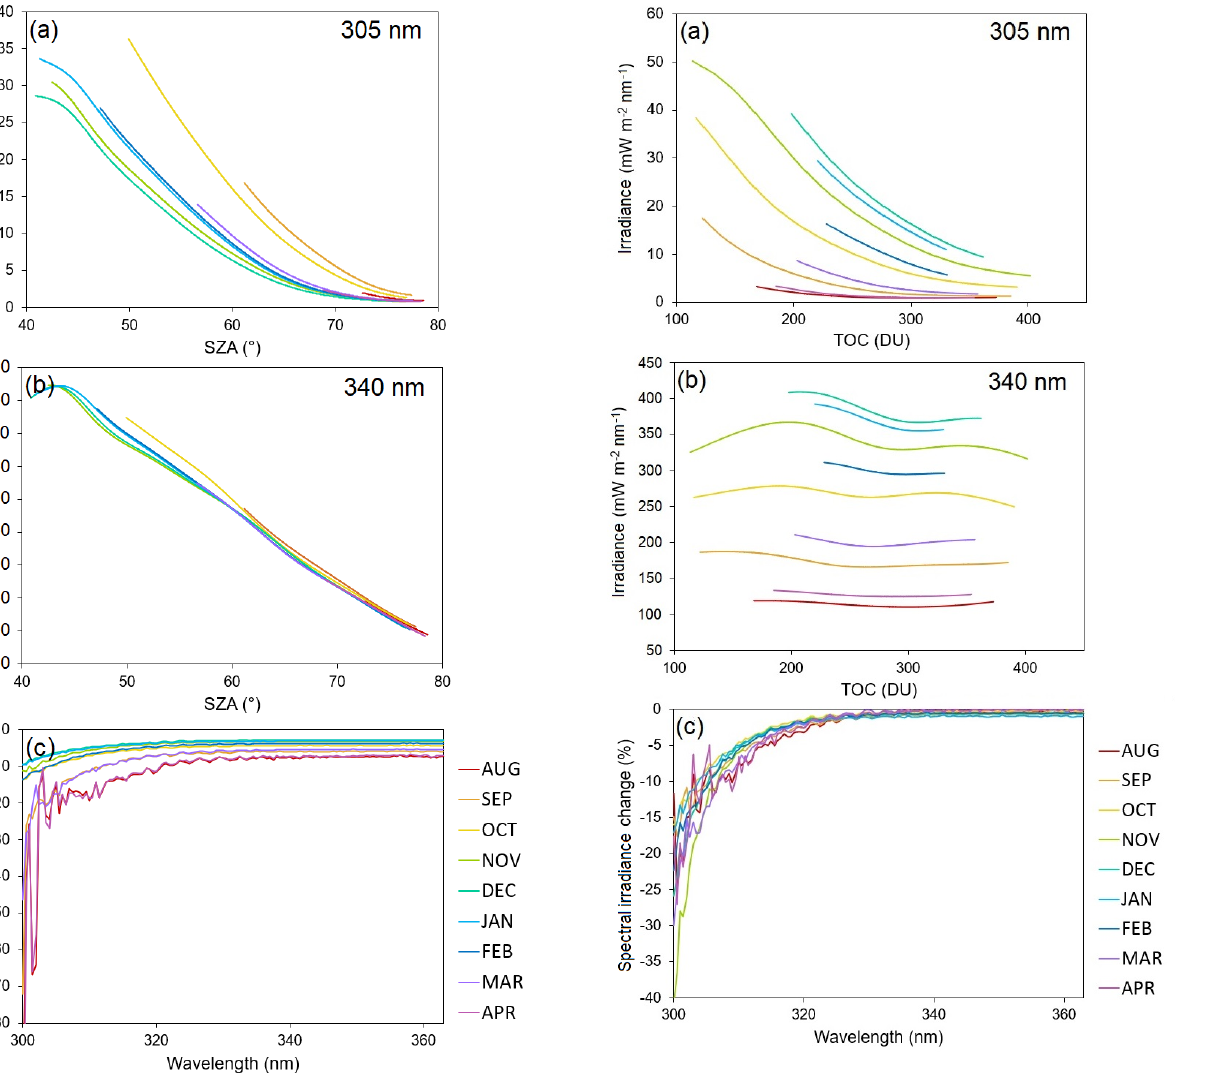
Figure 7. Modeled relationships between UV irradiance and SZA for different months. Panels (a) and (b) show the modeled UV ir- radiance at 305nm (a) and 340nm (b) as a function of SZA. Panel (c) shows the relative change in spectral UV irradiance resulting from an increase in SZA by 1 ◦ , calculated with reference to the monthly median spectra.